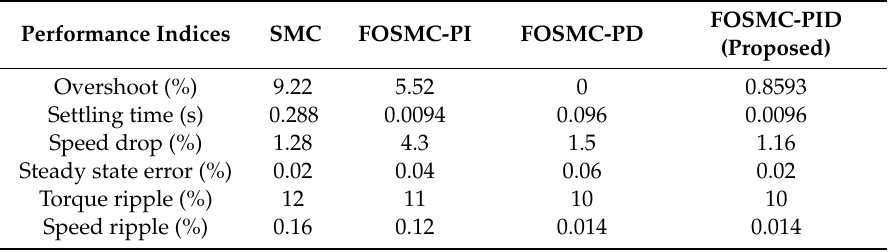
Table 2. Comparison of performance indices of the proposed controller with previous